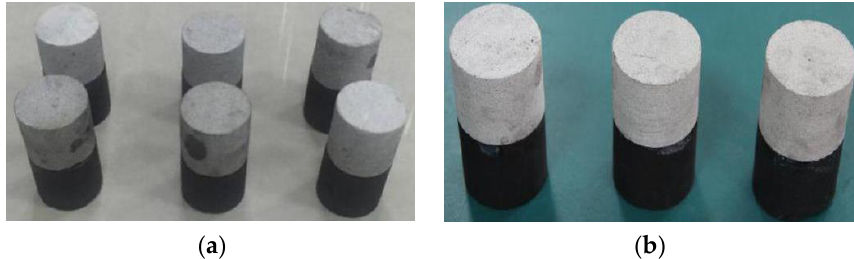
Figure 2. Sandstone-coal composite samples: ( a ) Sandstone-coal composite samples for creep tests; ( b ) Sandstone-coal composite samples for uniaxial compression tests. ( b ) Sandstone-coal composite samples for uniaxial compression